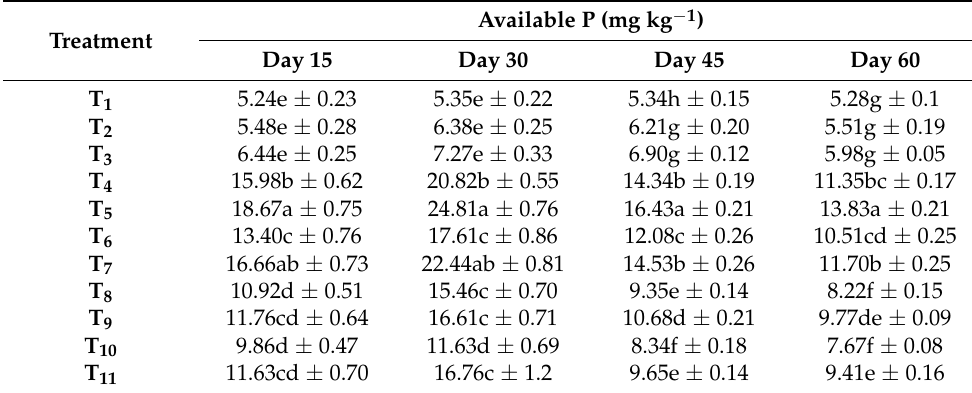
Table 7. Effect of RHB, EFBB, and dolomitic limestone treatments on soil available P. Treatment